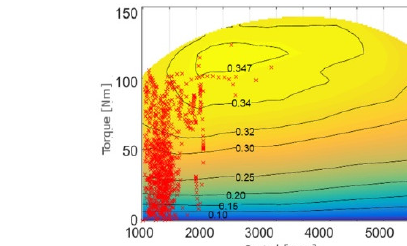
Figure 28. Series architecture: ICE working points.